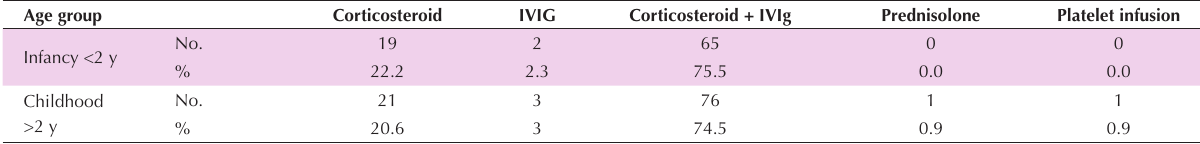
Table 2. Distribution of treatment methods in various age groups Age group